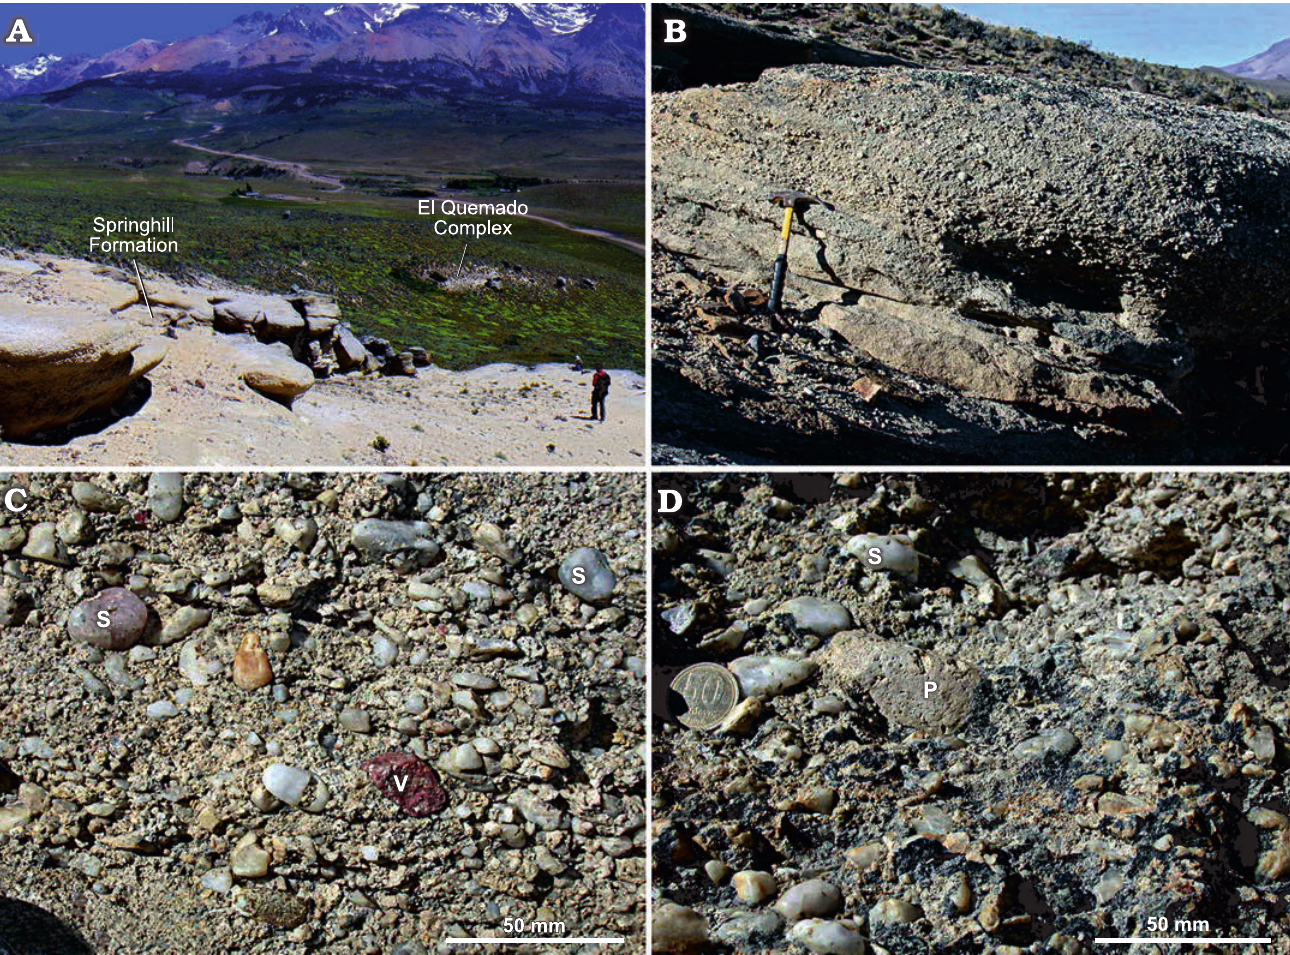
Fig. 2. Outcrops of the Springhill Formation in the Estancia El Álamo locality. A . Panoramic view of the Springhill Formation outcrop overlying the El Quemado Complex. B . Polymictic conglomerate beds with a sandstone bed intercalation, Springhill Formation. C . Detail of the polymictic conglomerate with siliceous (S) and volcanic (V) clasts. D . Pyroclastic (P) and siliceous (S) clasts in the